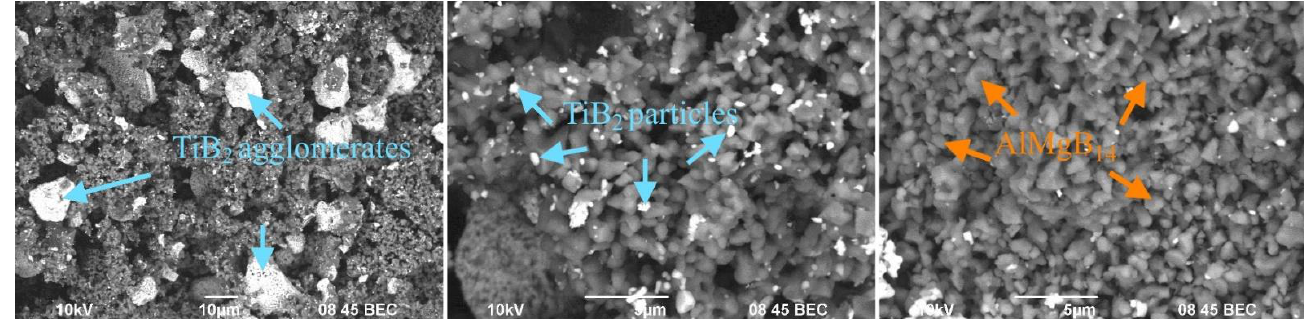
Figure 1. SEM images of the AlMgB 14 -TiB 2 precursor (backscattered electron).